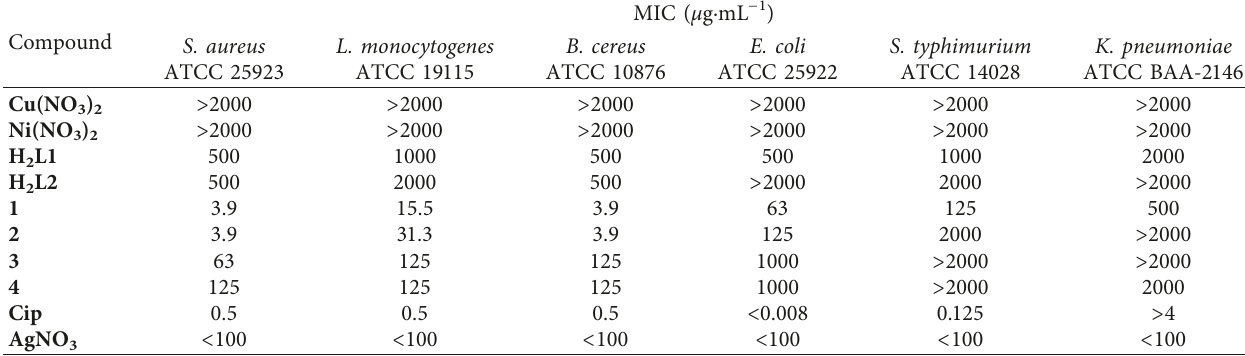
Table 5: Antibacterial activities of the studied